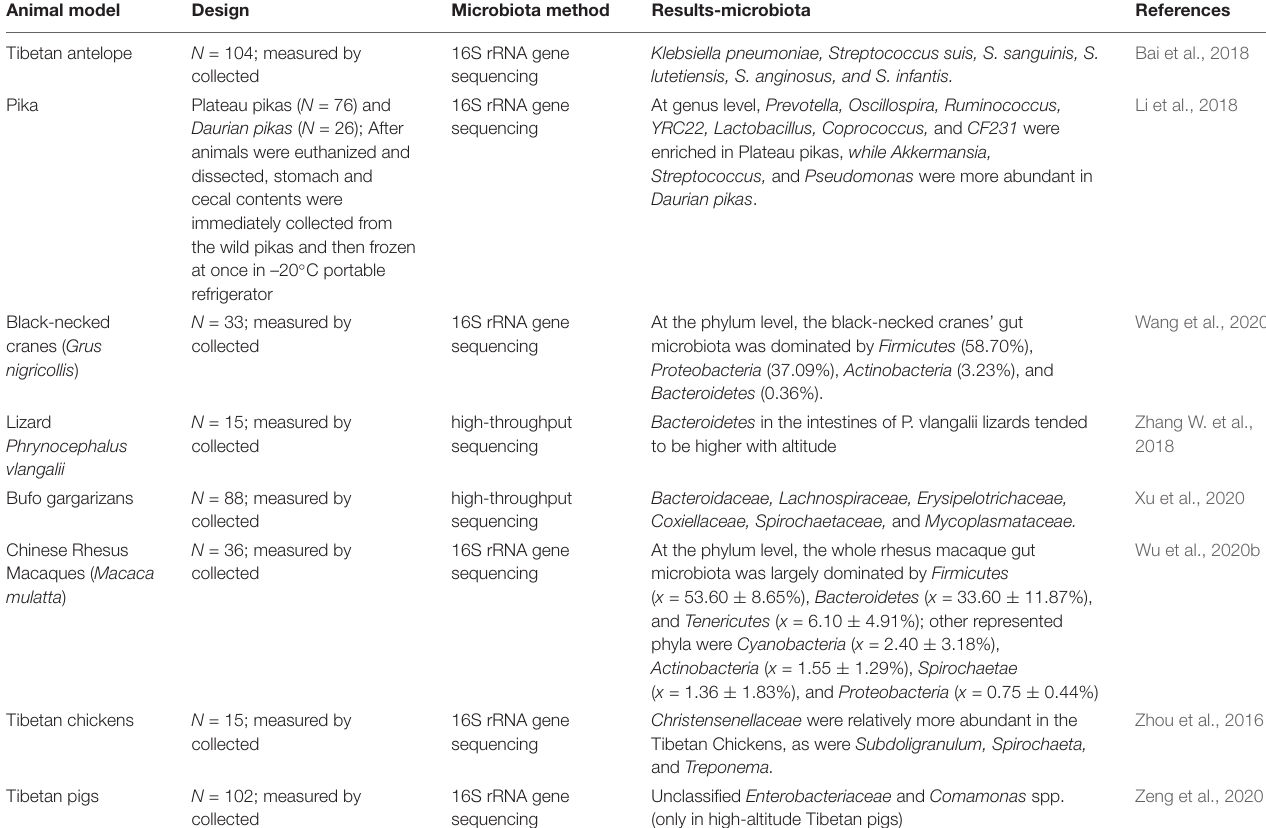
TABLE 1 | Gut microbiomes of animals living in plateau